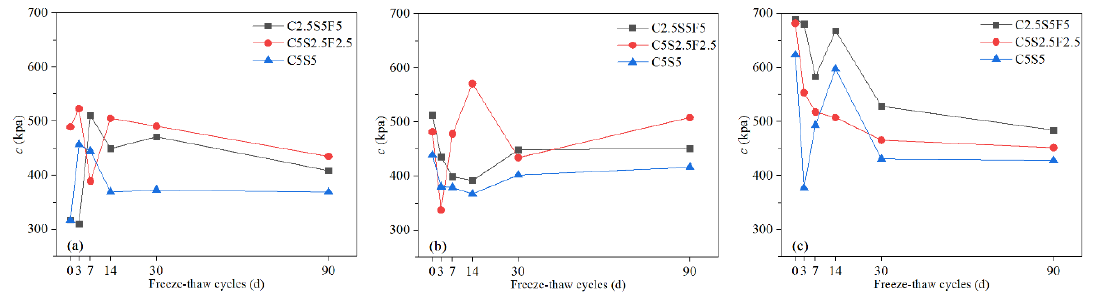
Figure 10. The c of Pb-CSCSs with the same compound binder but different contaminant contents: ( a ) C2.5S5F5; ( b ) C5S2.5F2.5, and ( c ) C5S5.